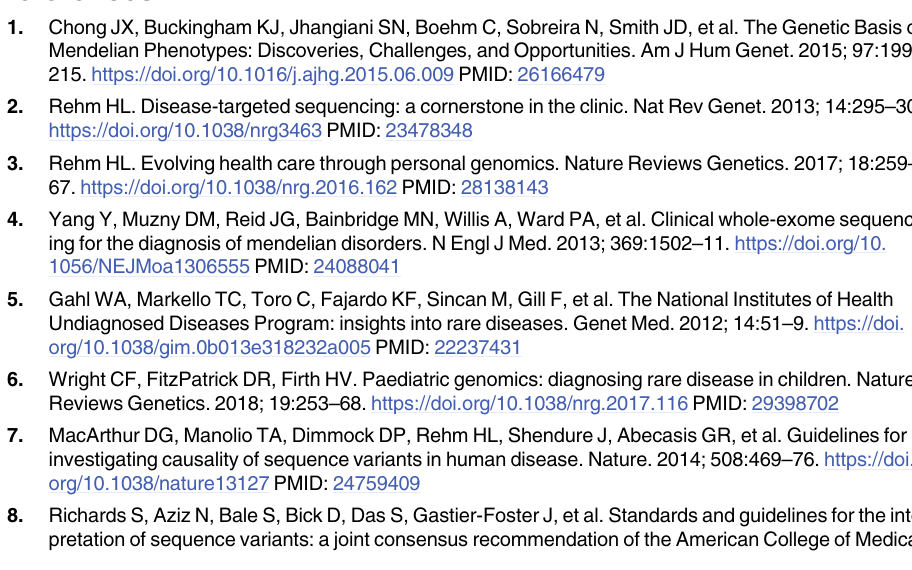
S17 Table. Evaluation of the contribution of the source of benign variants in the perfor- mance of MISTIC. The best performances are in bold. S18 Table. Evaluation of the impact of the high confidence training set of deleterious vari- ants on the performance of MISTIC. The best performances are in